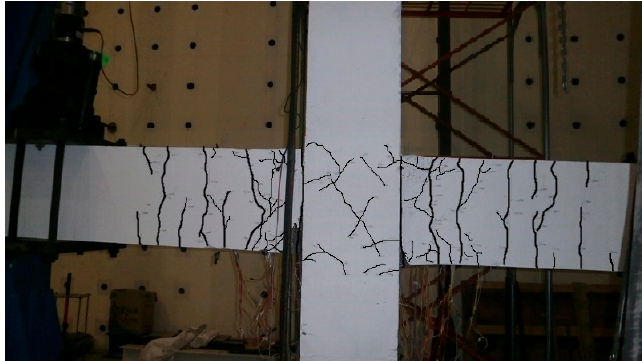
Figure 8. Distribution of cracks on the beam after yielding of the cast-in-place joint.